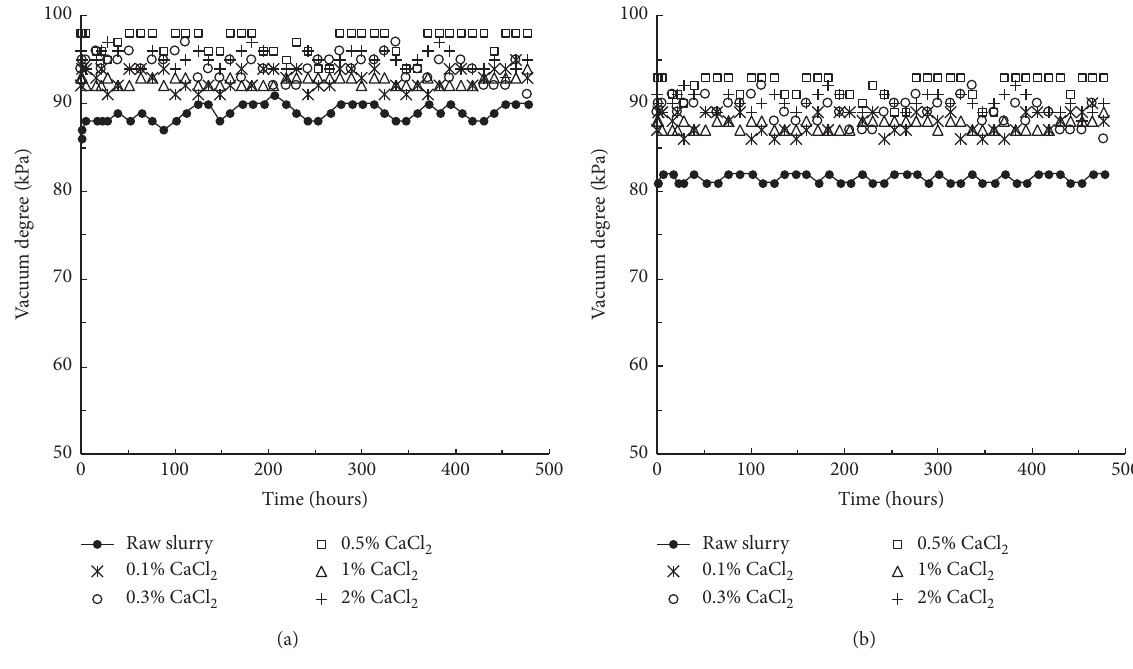
Figure 2: Vacuum degree versus time. (a) Top. (b) Bottom.